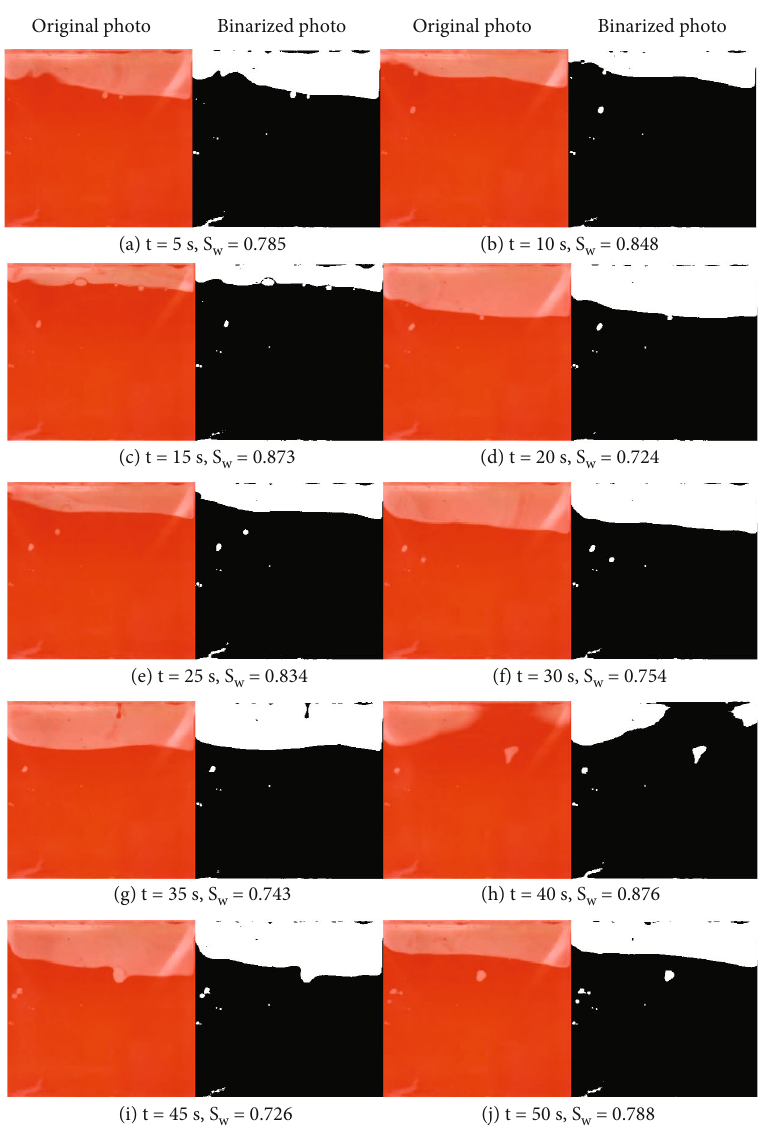
Figure 9: Saturations in fracture 5 at di ff erent moments when Wr = 500 mL/min and Gr = 1000 mL/min in case